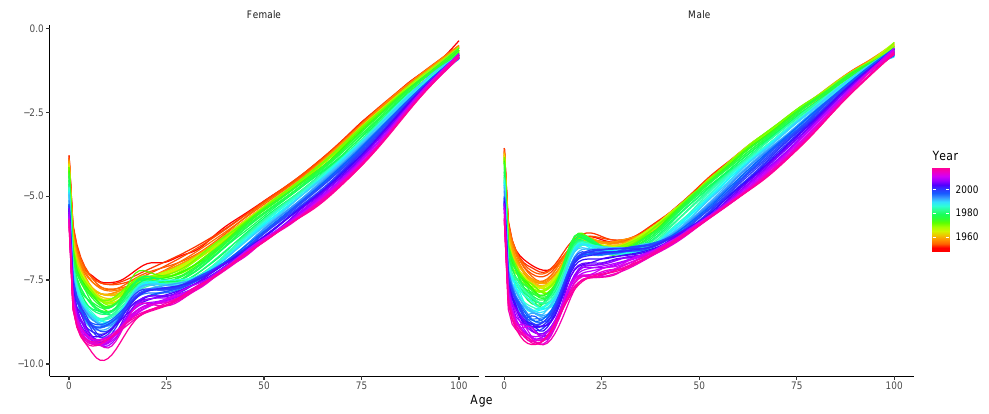
Figure 3. Log mortality rates for Australian population